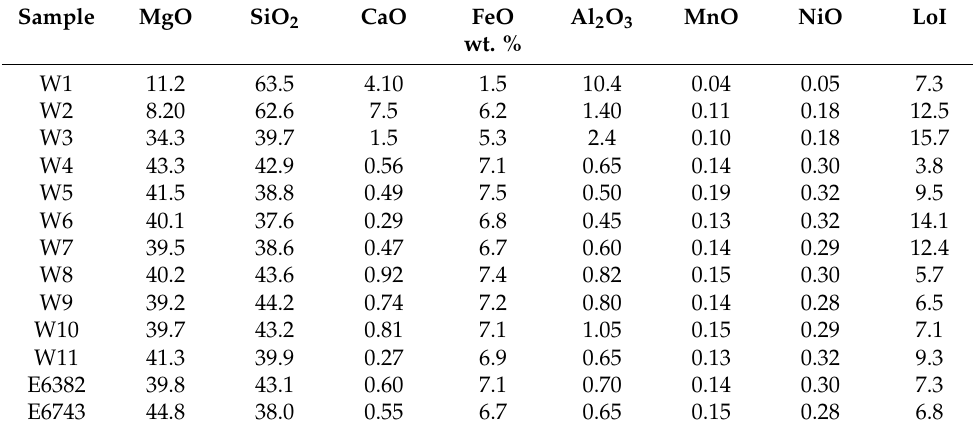
Table 1. Chemical analysis by Energy-Dispersive X-ray Fluorescence spectroscopy (XRF) and the respective loss of ignition (LoI).